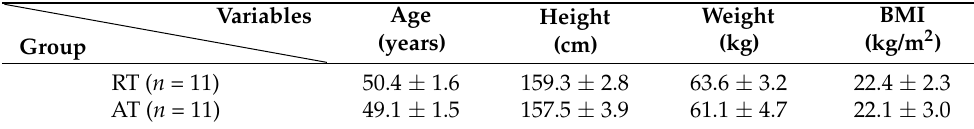
Table 1. General characteristics of the study subjects.